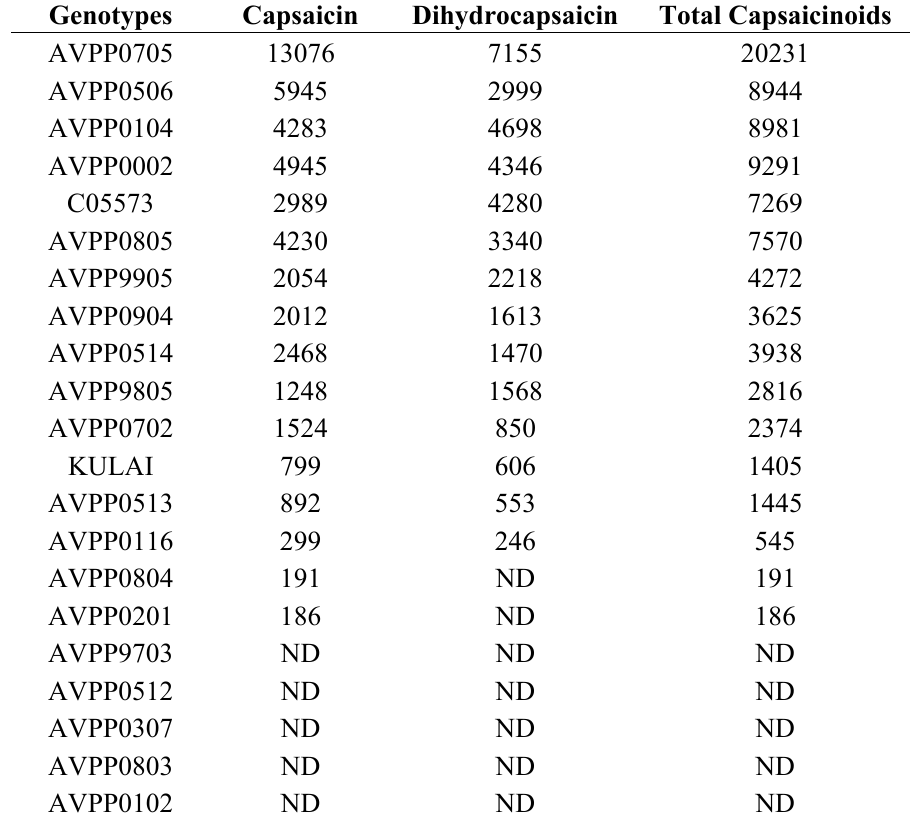
Table 5. The capsaicinoids content of the twenty-one chilli pepper genotype samples